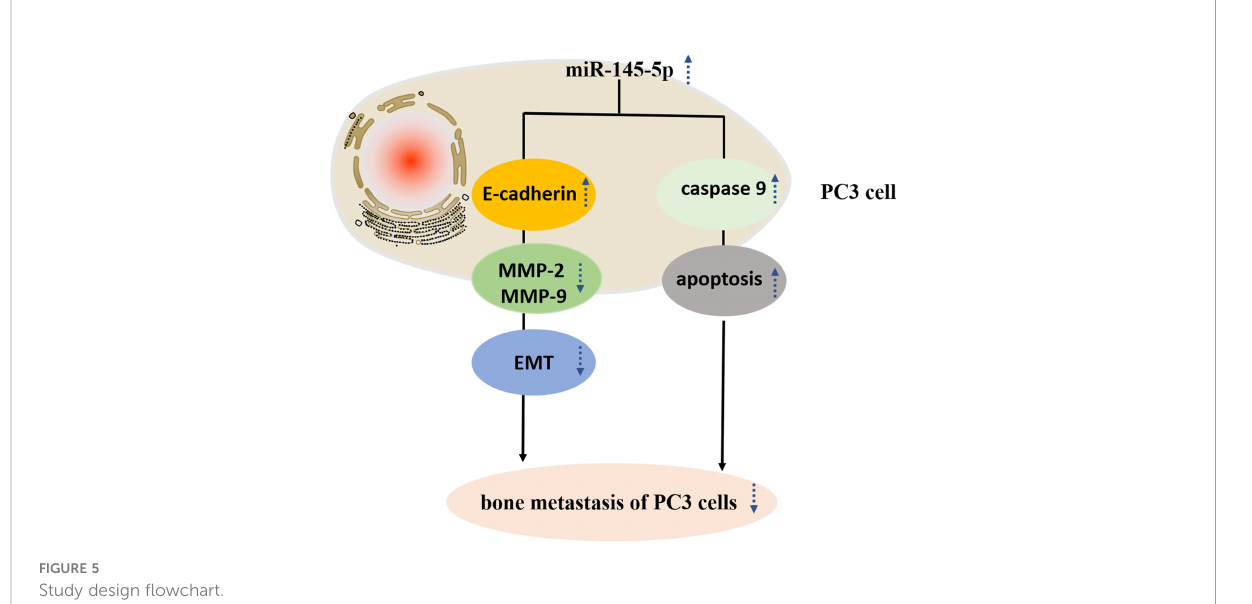
FIGURE 5 Study design fl